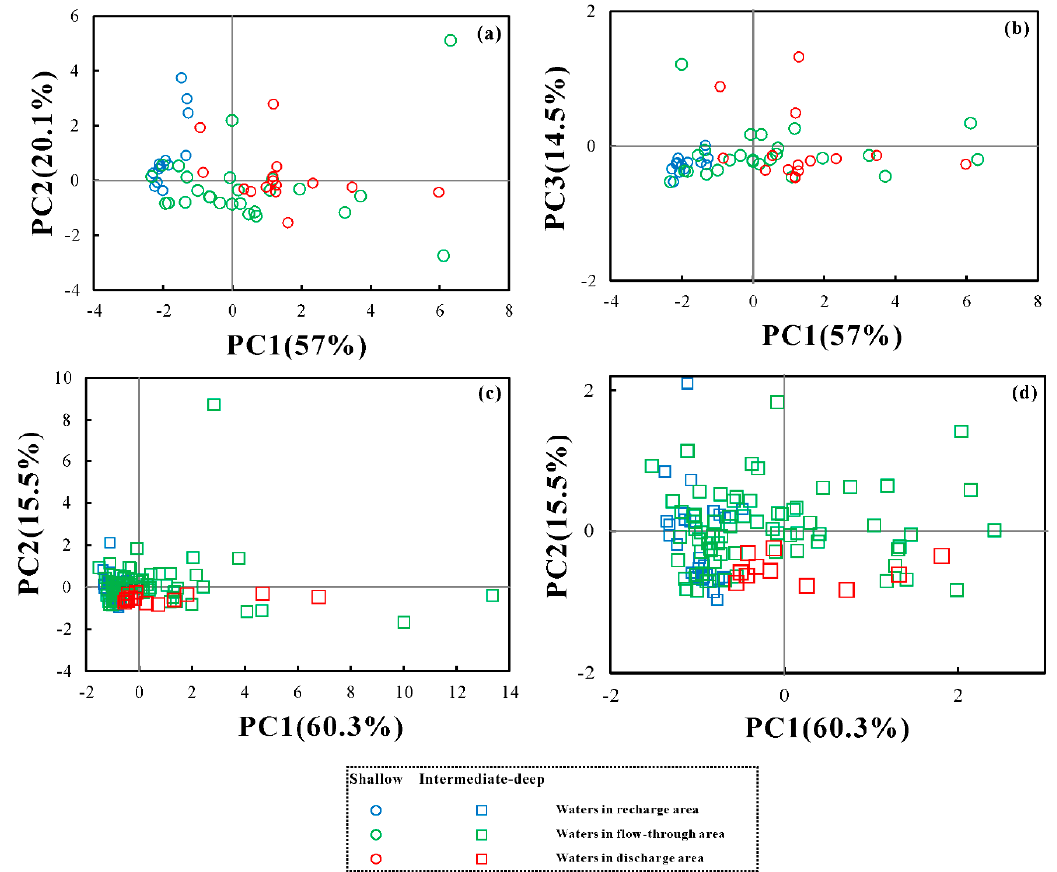
Figure 5. Component scores for shallow groundwater (a, b) and intermediate-deep groundwater samples (c, d) .